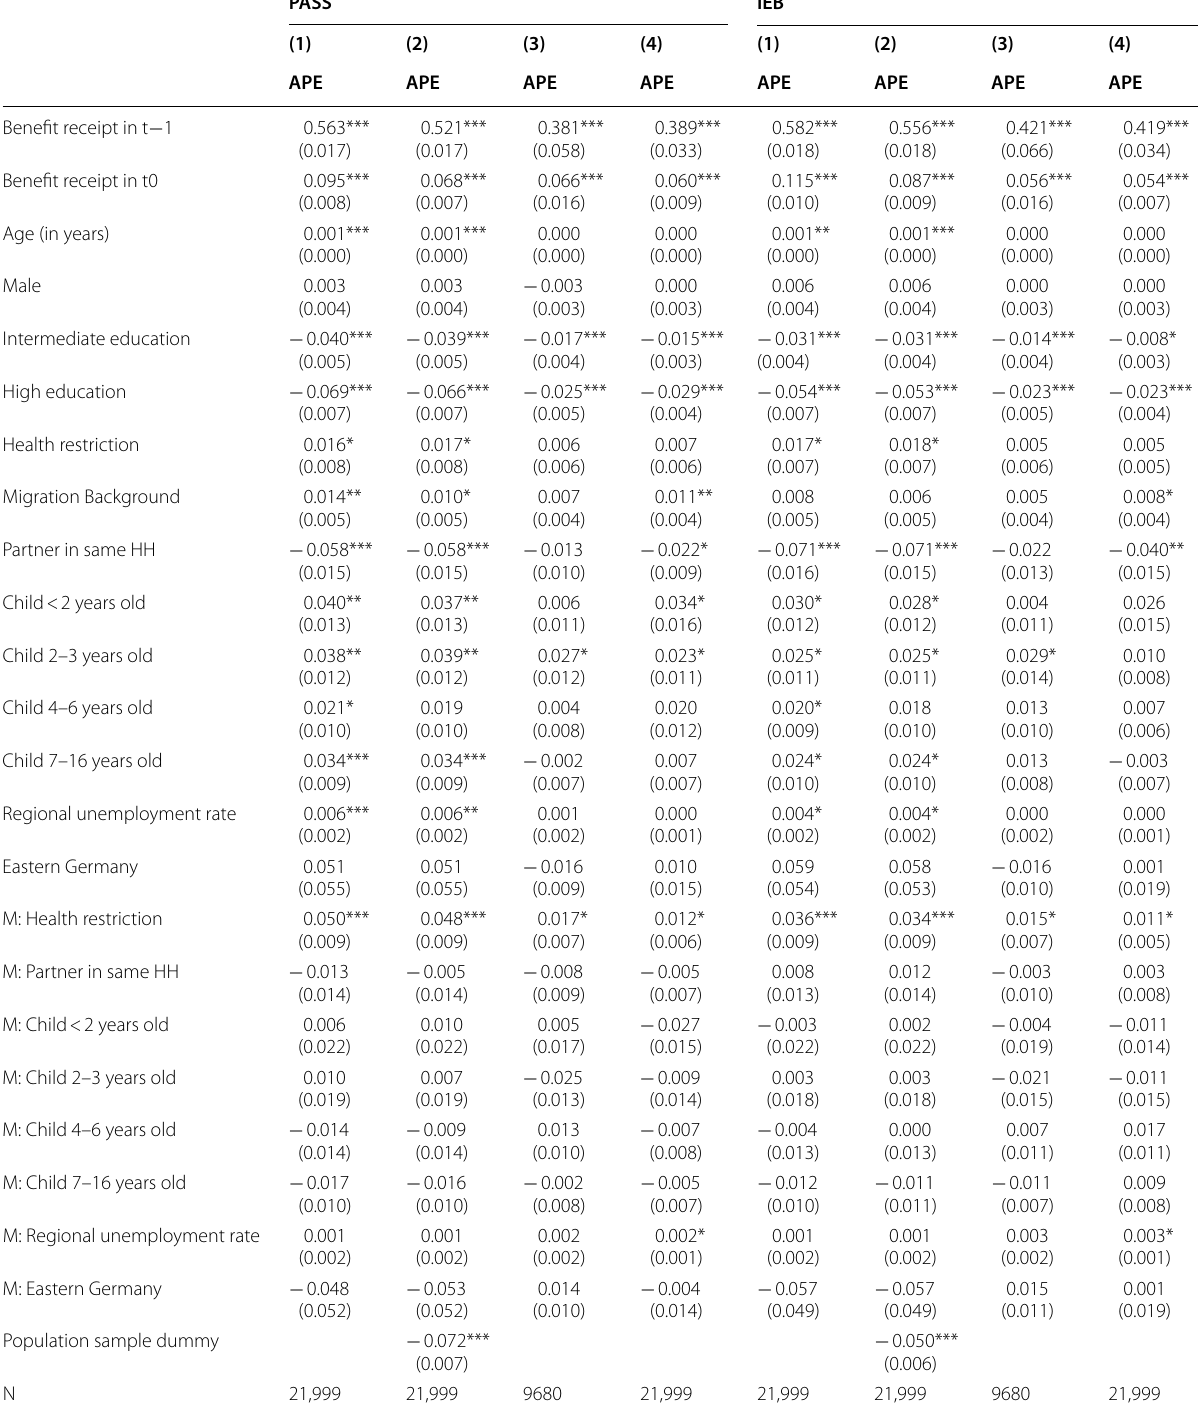
(1) Full sample, unweighted, (2) full sample, unweighted with population sample dummy (3) population sample only, unweighted (4) full sample, weighted; M individual average of covariate, S.E.: Standard errors clustered at the individual level in parantheses. ***/**/* denote statistical significance at the 0.001, 0.01, 0.05 = levels, respectively. Source: